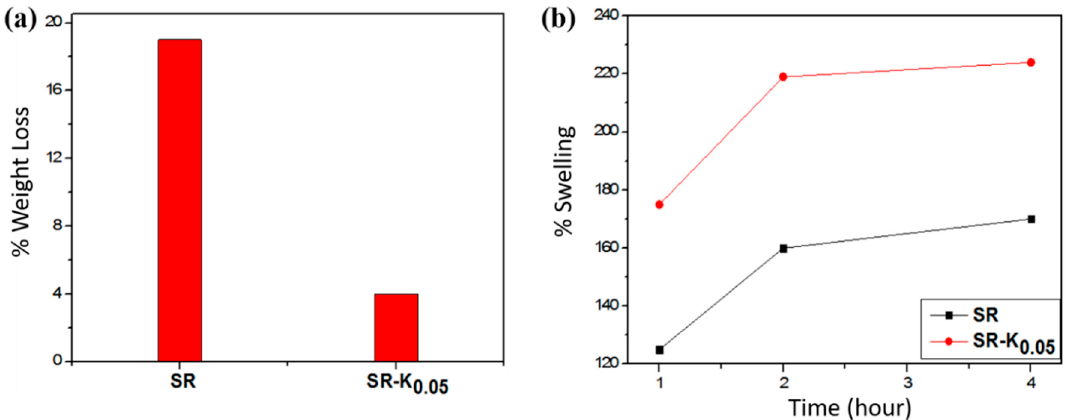
Figure 5. ( a ) Effect of toluene on percent weight loss (SR-K 0.05 showed reduced weight loss compared with unfilled SR); ( b ) degree of swelling vs. time (SR-K 0.05 showed comparatively better swelling behavior in toluene than SR.).